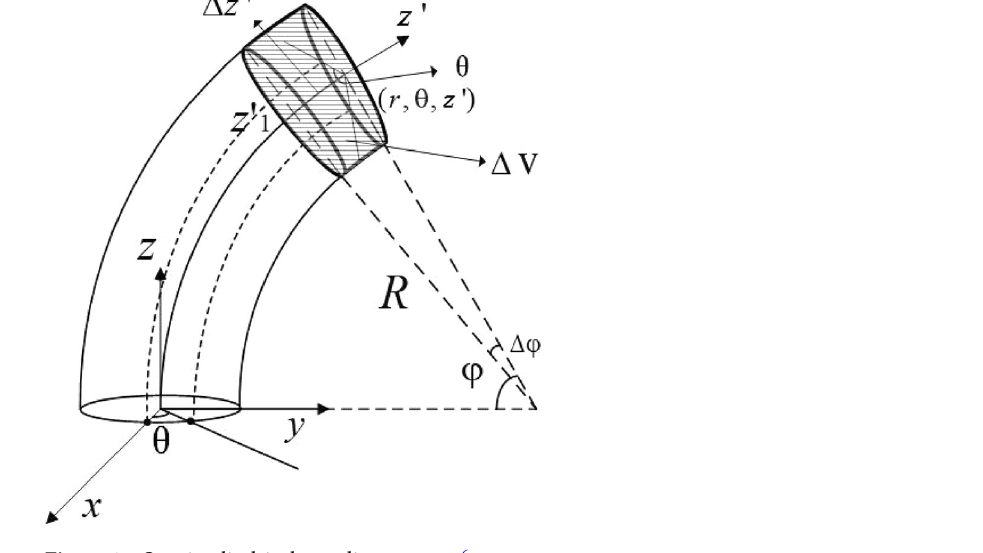
Figure 1. Quasi-cylindrical coordinate system 6